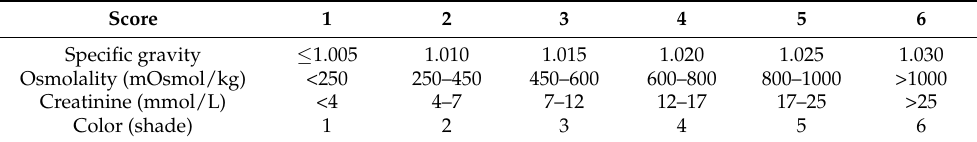
Table 1. Description of the four dimensions of the fluid retention index